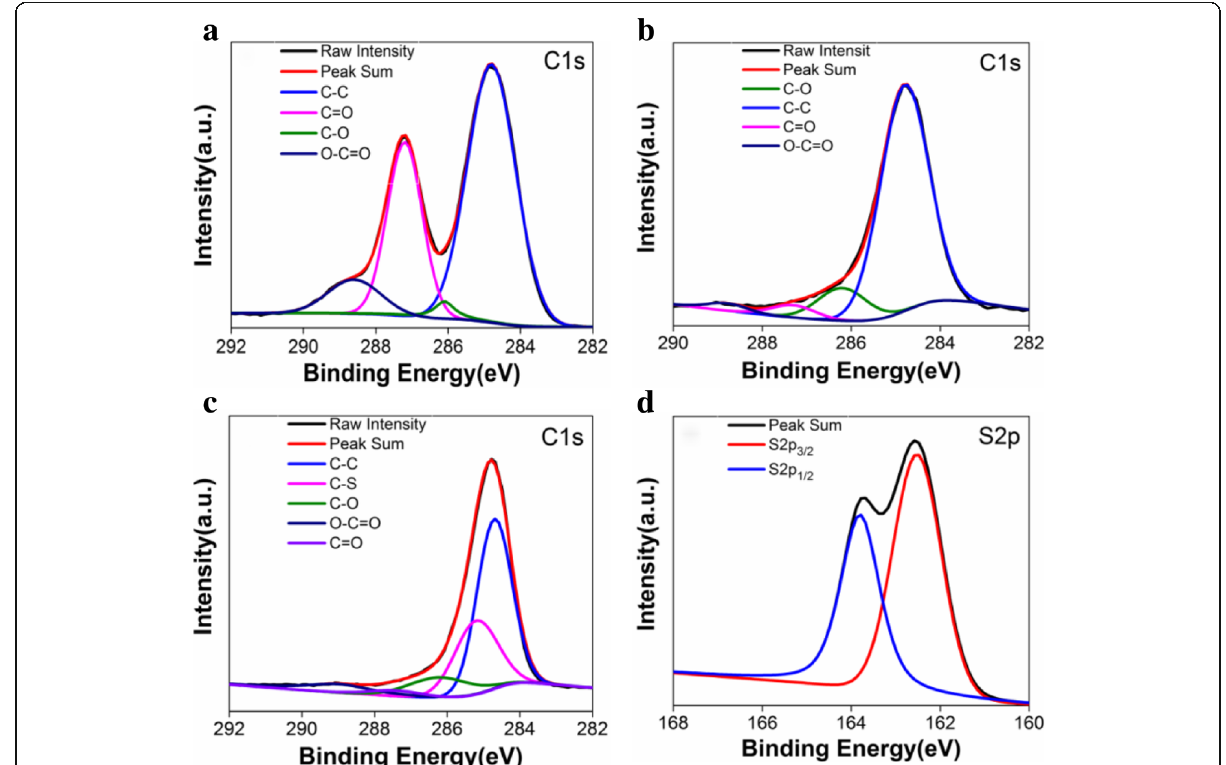
Fig. 4 The survey XPS spectrum for C1 s peaks of a GO, b rGO, and c rGO/PEDOT and d S2 p peak of rGO/PEDOT